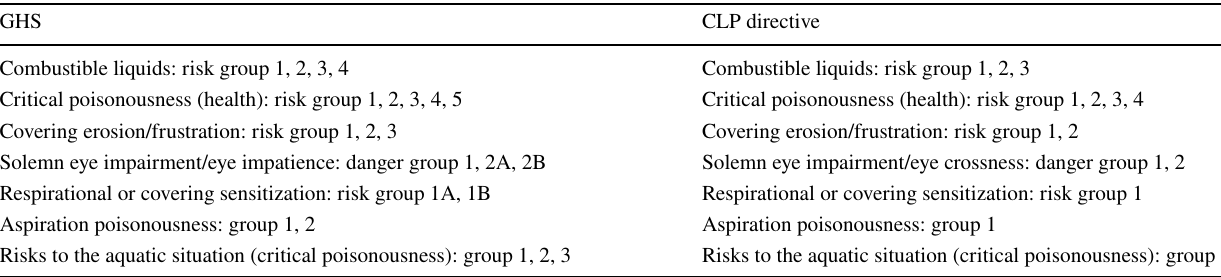
Table 1 Changes in session/risk groups between GHS and CLP parameters